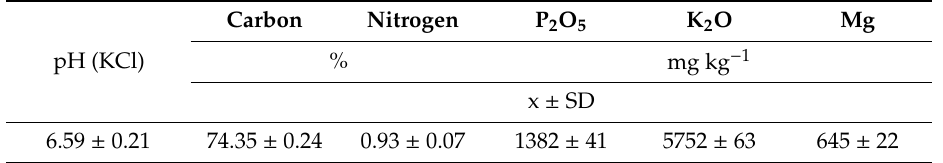
Table 1. The pH value of the biochar, with the content of the absorbable forms of macro-elements and the percent content of carbon and nitrogen in the biochar. x—mean, SD—standard deviation.